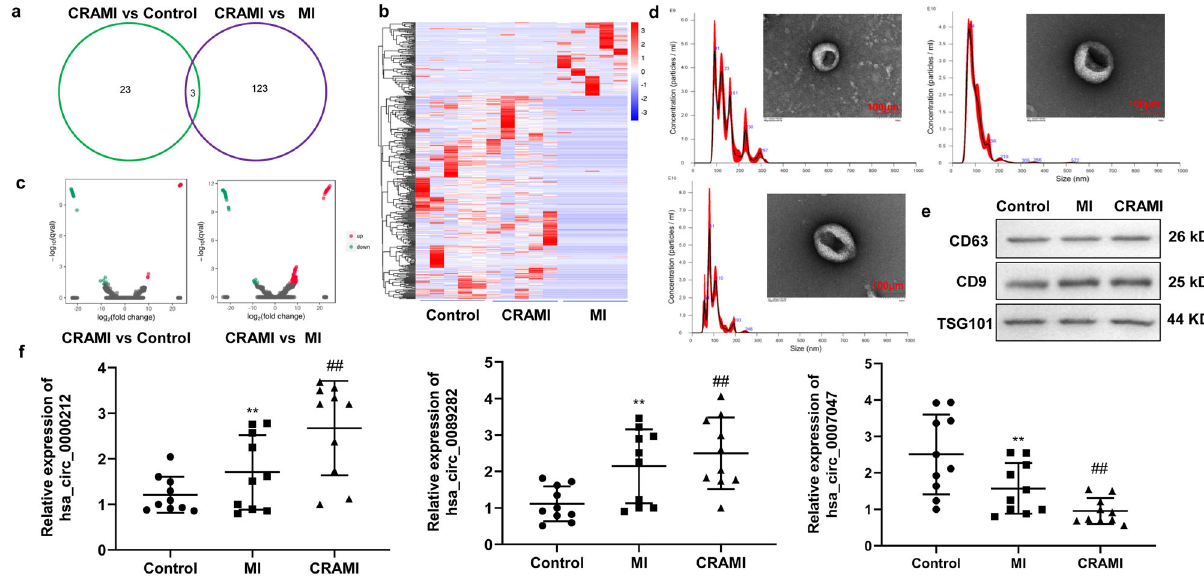
Fig. 1 circCEBPZOS was signi fi cantly downregulated in the serum EVs of patients with postinfarct cardiac remodeling. a Venn diagram to present the number of differentially expressed circRNAs among the serum exosomes from patients with and without postinfarct cardiac remodeling using whole transcriptome sequencing. b , c Heatmap and volcano plot to present the expression of differentially expressed circRNAs, respectively. d Phenotype of exosomes isolated from serum from patients with and without postinfarct cardiac remodeling by transmission electron microscopy, Bar = 100 μ m; the particle size of exosomes identi fi ed by nanoparticle tracking analysis. e Protein expression of CD6, CD9 and TSG101 was detected using western blotting. f Expression of hsa_circ_0000212, hsa_circ_0089282 and circCEBPZOS in exosomes from patients with and without postinfarct cardiac remodeling by